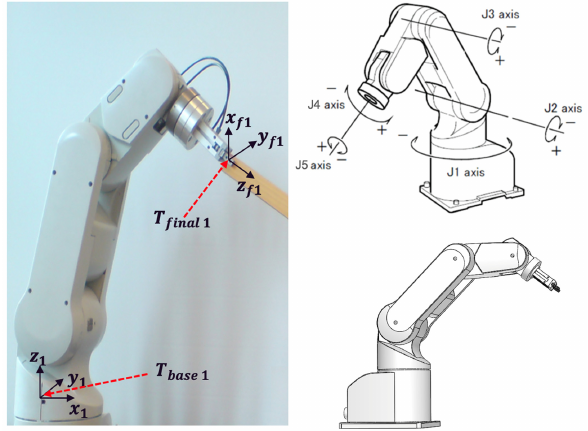
Figure 2. Mechanical body of the investigated RV-2AJ robot arm.